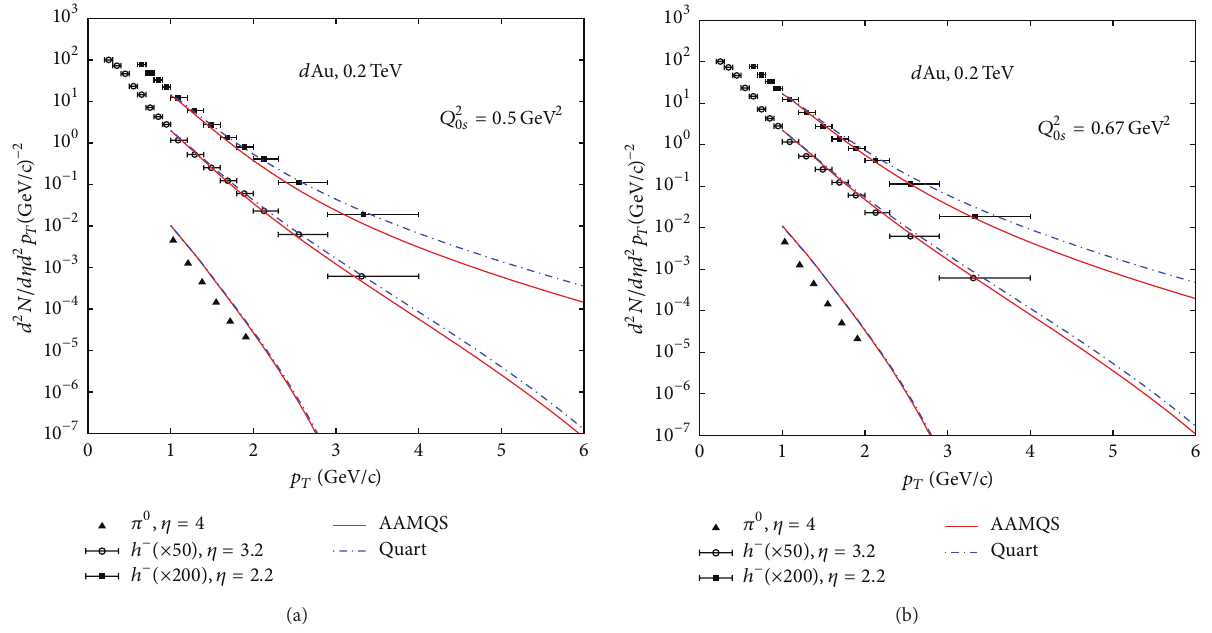
Figure 6: Same as Figure 3, but for minimum-bias 𝑑 + Au collisions with 𝑄 2 0𝑠 = 0.5 GeV 2 (a) and 0.67 GeV 2 (b) in the calculations.